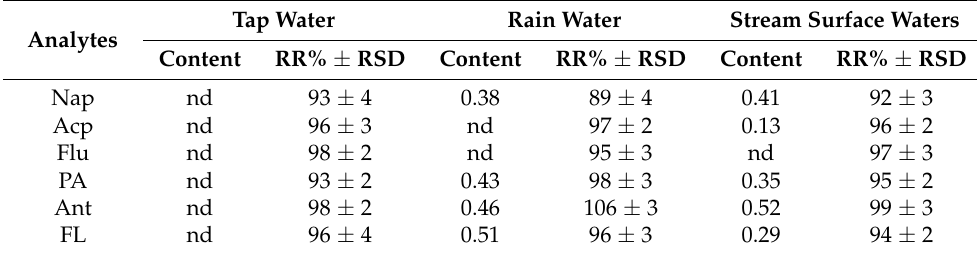
Table 4. PAHs content and recoveries for three different kinds of spiked